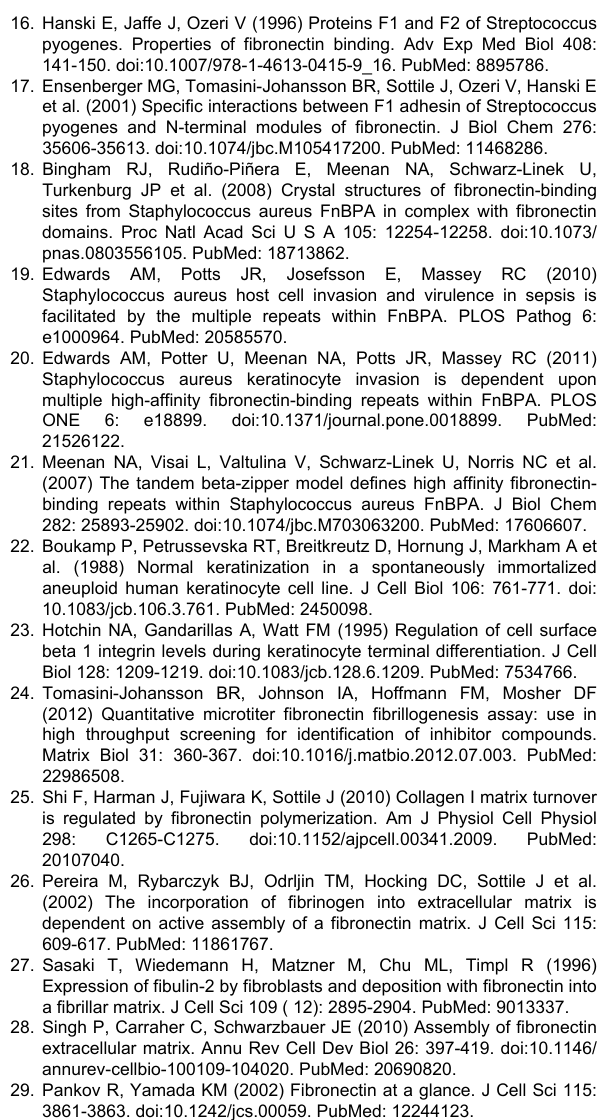
Figure S3. Effect of adhesion inhibitors on host cellular adhesion in the absence of serum. Adhesion of HaCaT (a), HDF (b) or HeLa cells (c) to culture vessels was measured following 2 hours (black) or 12 hours (grey) of incubation in serum-free medium alone (no inhibitor, NI) or medium containing 500 nM bead-immobilized GST (CB), MAM7, F1 or FnBPA peptide. Results are means ± standard deviation from one of a set of three experiments done in triplicate. Values significantly different from the control (p<0.01 according to student t-test) are indicated